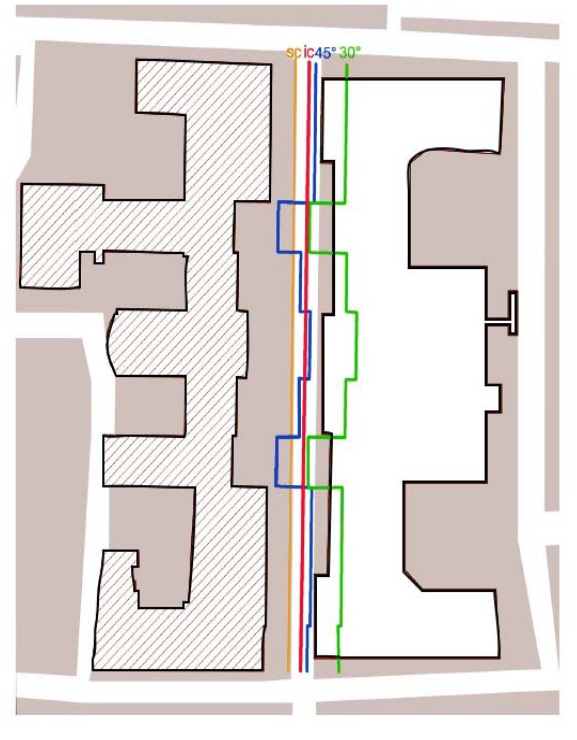
Figure 12. Upper, representation of the laser scanner and three- dimensional laser beam projections of the cones taken during Figure 13. The rails used to conduct the survey: in red, the the standard survey campaign. Lower, representation of the Customized Condition (IC) between the ideal situation (green laser scanner and three-dimensional laser beam projections of rail) and the scanning carried out (orange rail). Behind it, the the cones contained within a maximum inclination of 30° one with a maximum beam angle of up to 45° (blue rail) – obtained from the ideal survey – graphic elaboration by Maria graphic elaboration by Maria Chiara Chiara Pugliese